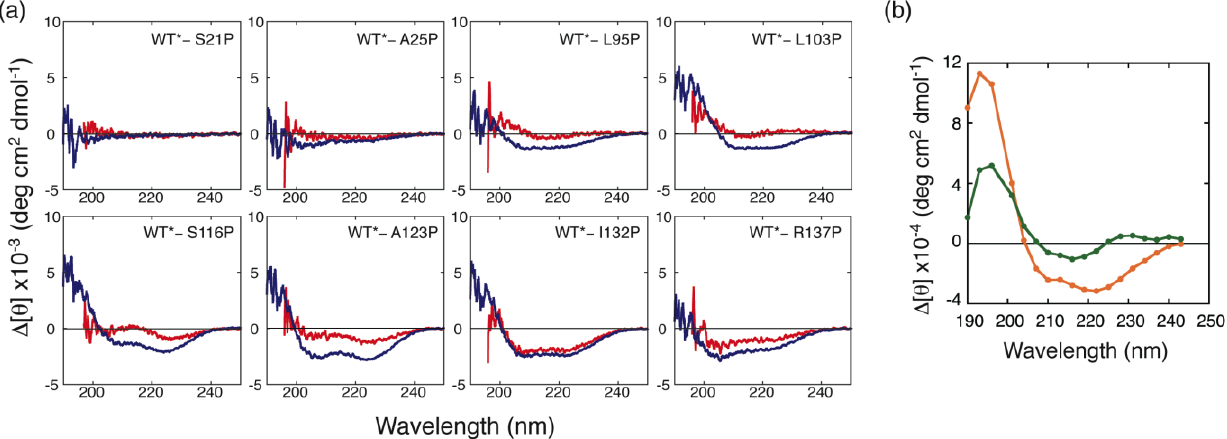
Figure 5. (a) Differences in CD spectra between the mutants and WT* in the A and C states (shown in red and blue, respectively) and (b) differences in CD spectra between  -helix and unordered form (orange) and between  -sheet and unordered form (green)